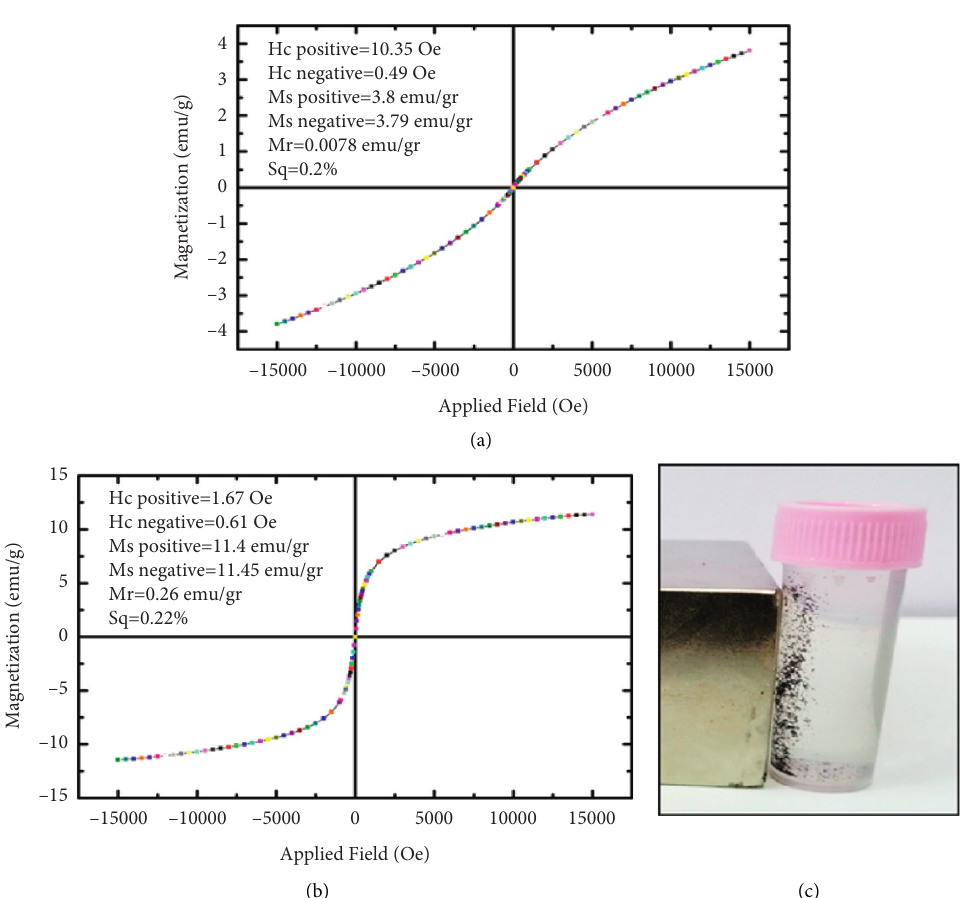
Figure 10: Magnetization activity of the synthesized NPs measured with VSM. (a) VSM without external magnetic field and (b) VSM with external magnetic field. (c) The photograph shows the effects of external magnetic field on the